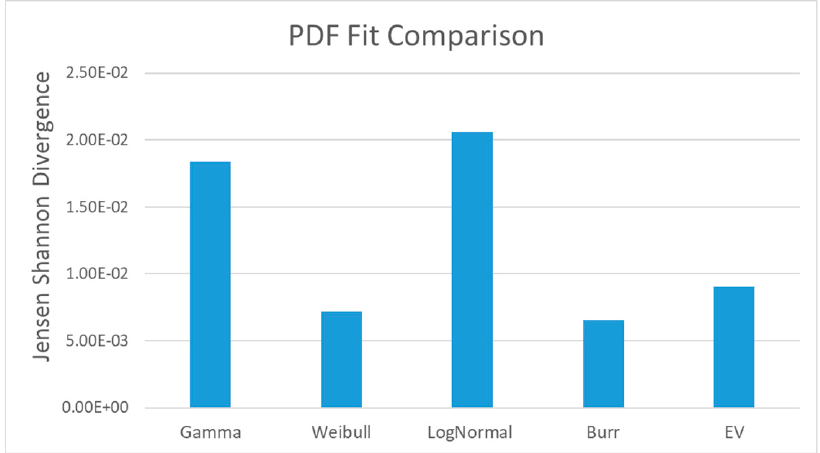
Figure 7. The Jensen–Shannon divergence values for Gamma, Weibull, Lognormal, Burr and Extreme-Value distribution.